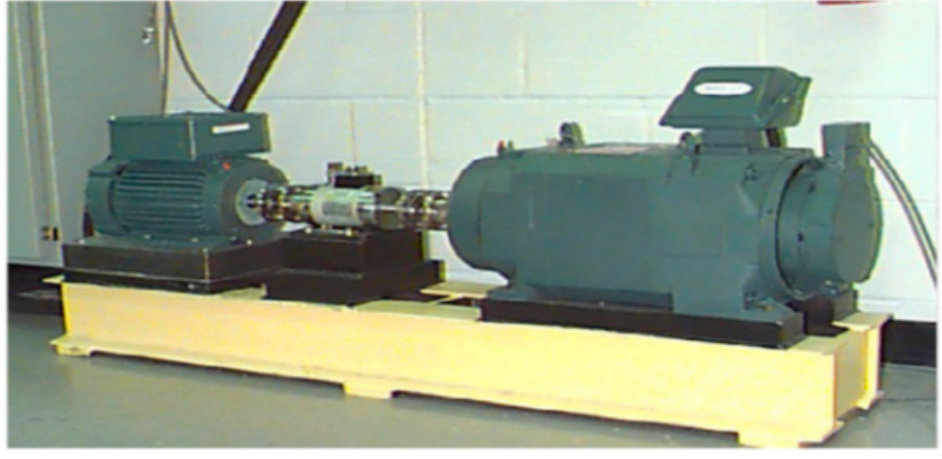
Figure 7. Equipment of experimental platform.